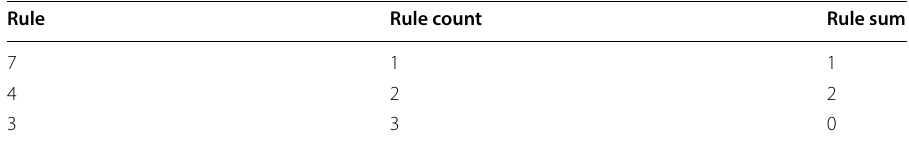
Table 5 Reducer results